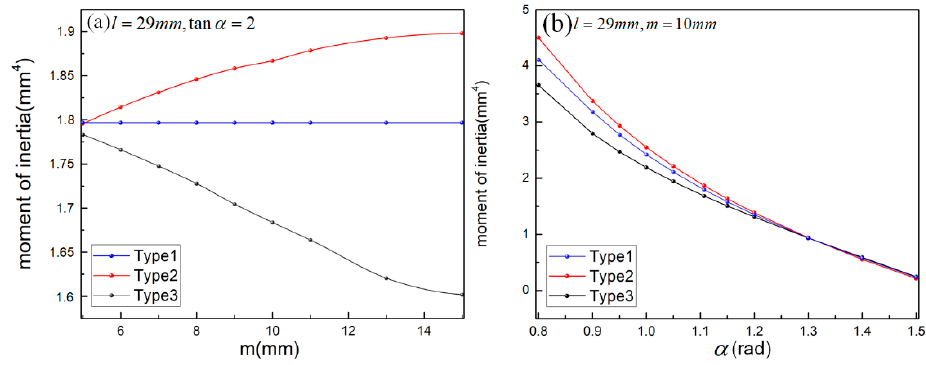
(18) In the design of the rails, in order to ensure a smooth contact surface, it is necessary